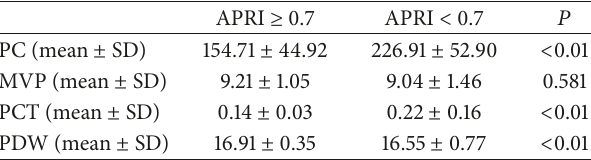
Table 4: APRI score according to platelet count and